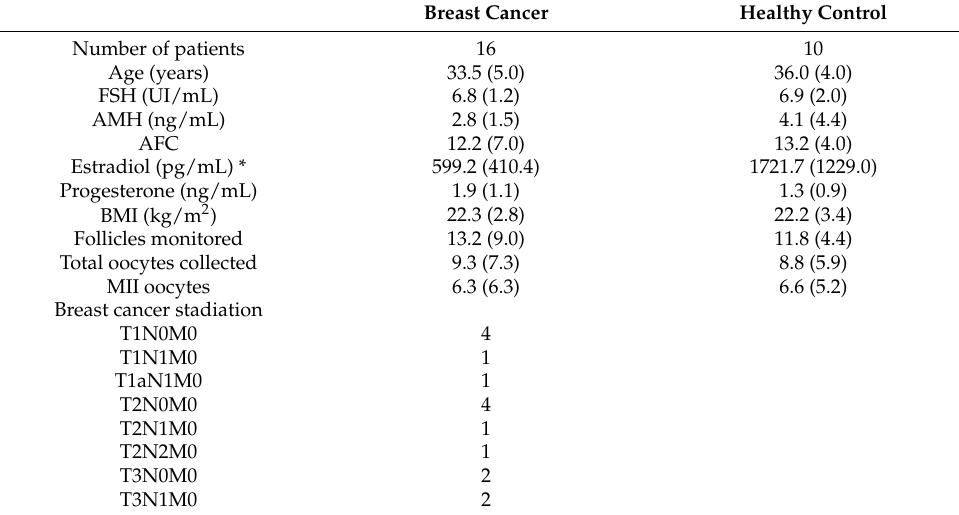
Table 1. Clinical data of the 26 women participating in the study. Breast Cancer Healthy